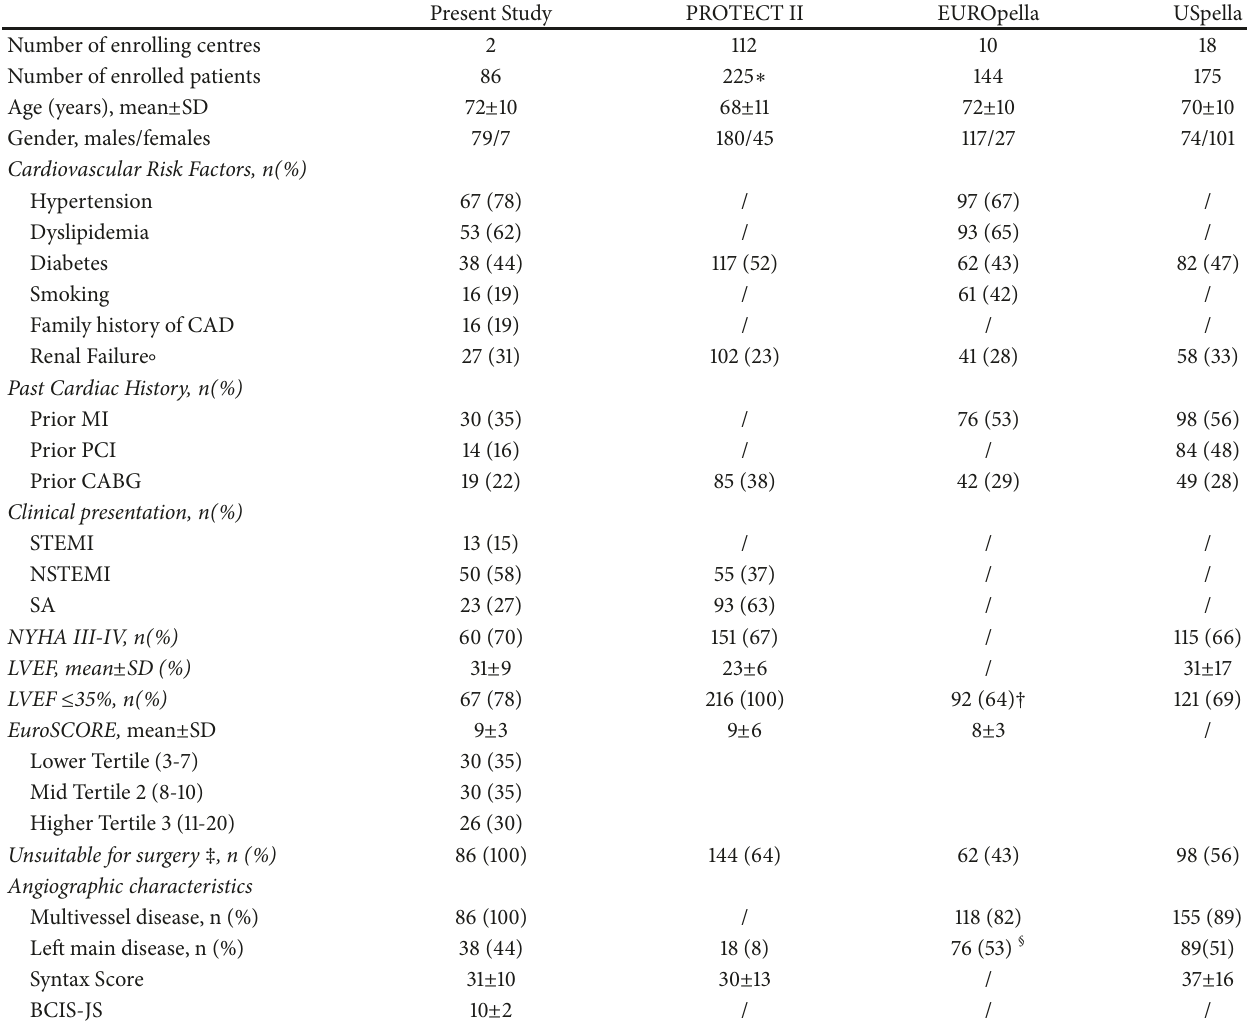
Table 1: Baseline characteristics of study